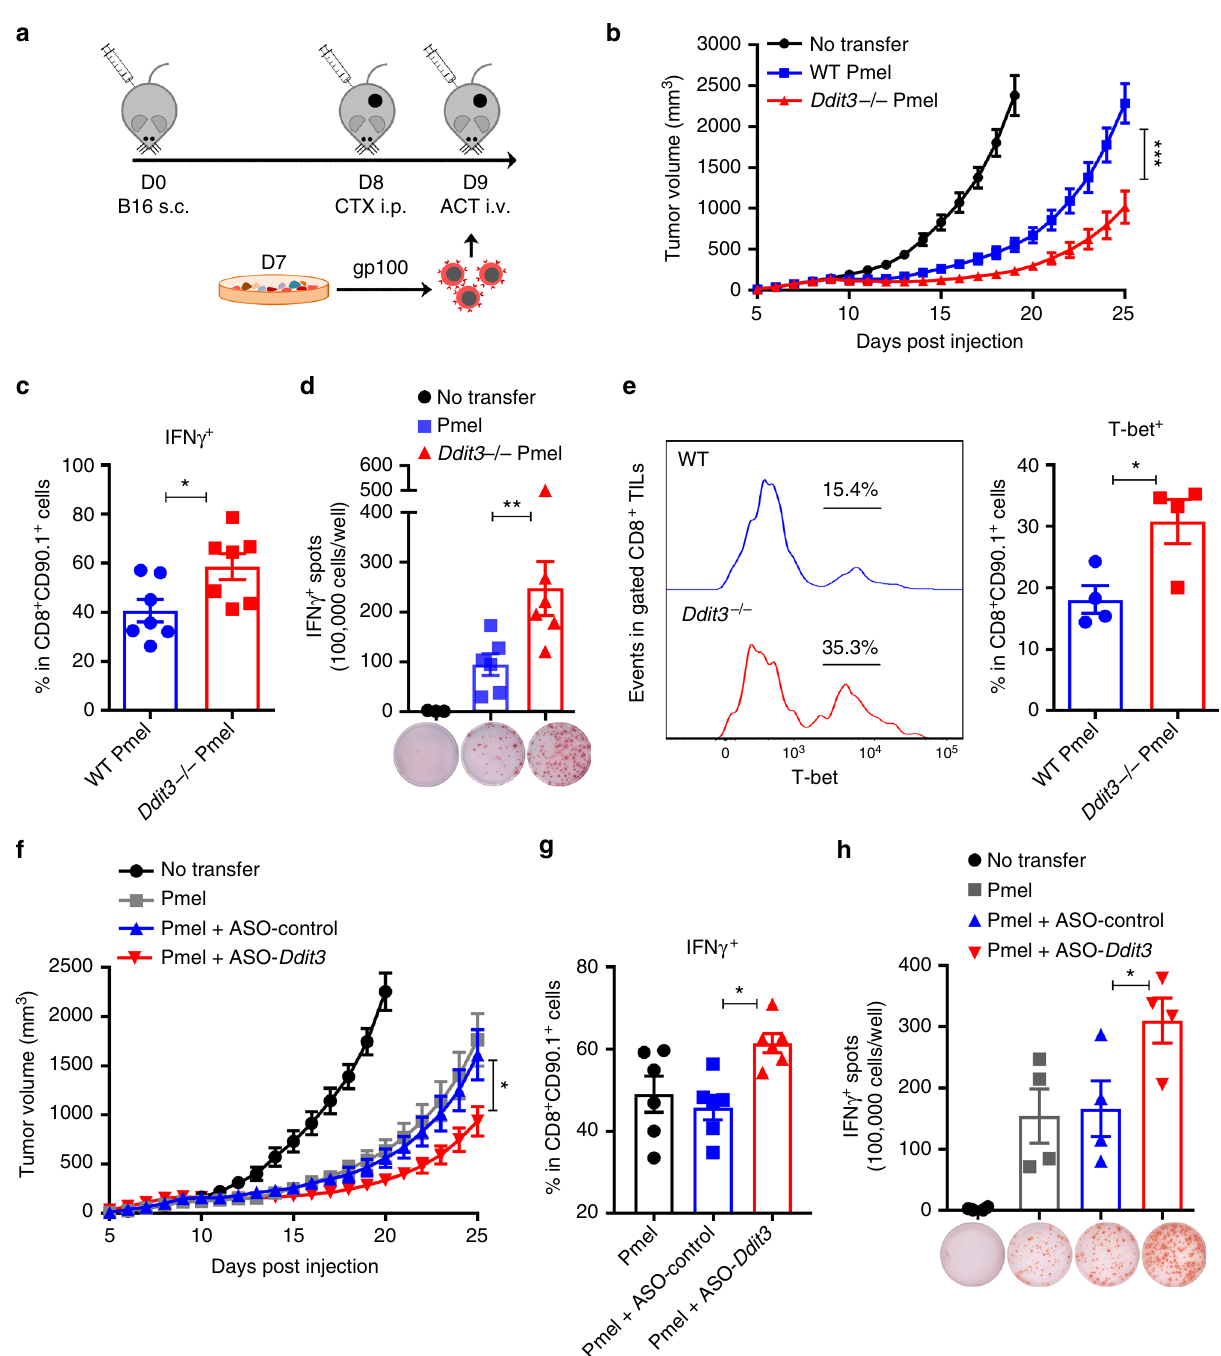
Fig. 6 Ddit3 deletion or silencing increases the effect of T cell-based immunotherapy. a Working model of Pmel T cell adoptive transfer. CD90.2 + wild-type mice were injected subcutaneous with B16 tumors, and after 8 days, they received a single dose of cyclophosphamide (CTX). The next day, mice received 1 × 10 6 primed wild-type or Ddit3 − / − or anti-sense oligonucleotide (ASO)-treated CD90.1 + CD8 + Pmel T cells. b Tumor growth in B16-bearing mice (black) transferred with wild-type (blue) or Ddit3 − / − (red) CD90.1 + CD8 + Pmel T cells. Average kinetics of tumor volume ± s.e.m. in 9 mice/group. c Percentage of IFN γ + cells in CD90.1 + CD8 + tumor-in fi ltrating T lymphocytes (TILs) from B16 tumors 5 days after wild-type or Ddit3 − / − CD8 + Pmel T cell transfer. ( n = 7 tumors/group). d ELISpot for interferon- γ (IFN γ ) in the spleens of B16 tumor-bearing mice 5 days after wild-type or Ddit3 − / − Pmel T cell transfer exposed to gp100 25 – 33 for 24 h. ( n = 6 spleens/group). e T-bet in CD90.1 + CD8 + TILs from B16 tumors 5 days after wild-type or Ddit3 − / − CD8 + Pmel T cell transfer. Right: representative result; left: merged results from n = 4/group. f Tumor growth in B16-bearing CD90.2 + mice (black) that received wild-type CD90.1 + CD8 + Pmel T cells that were non-treated (gray) or pretreated with ASO-Control (blue) or ASO- Ddit3 (red). Average tumor volume kinetics ± s.e.m. of 8 mice/group. g Percentage of IFN γ + in CD90.1 + CD8 + TILs from B16 tumor-bearing mice transferred with control, ASO- Control, or ASO- Ddit3 -pretreated CD90.1 + Pmel T cells. ( n = 6 tumors/group). h IFN γ ELISpot in spleens collected from B16 tumor-bearing mice treated with Pmel T cells or ASO-Control or ASO- Ddit3 -pretreated Pmel T cells. Spleens were collected 5 days after T cell transfer and exposed 24 h to gp100 25 – 33 . ( n = 4). Bar graphs show mean value ± s.e.m. and * p < 0.05, *** p < 0.001 were calculated using two-tailed unpaired Student ’ s t